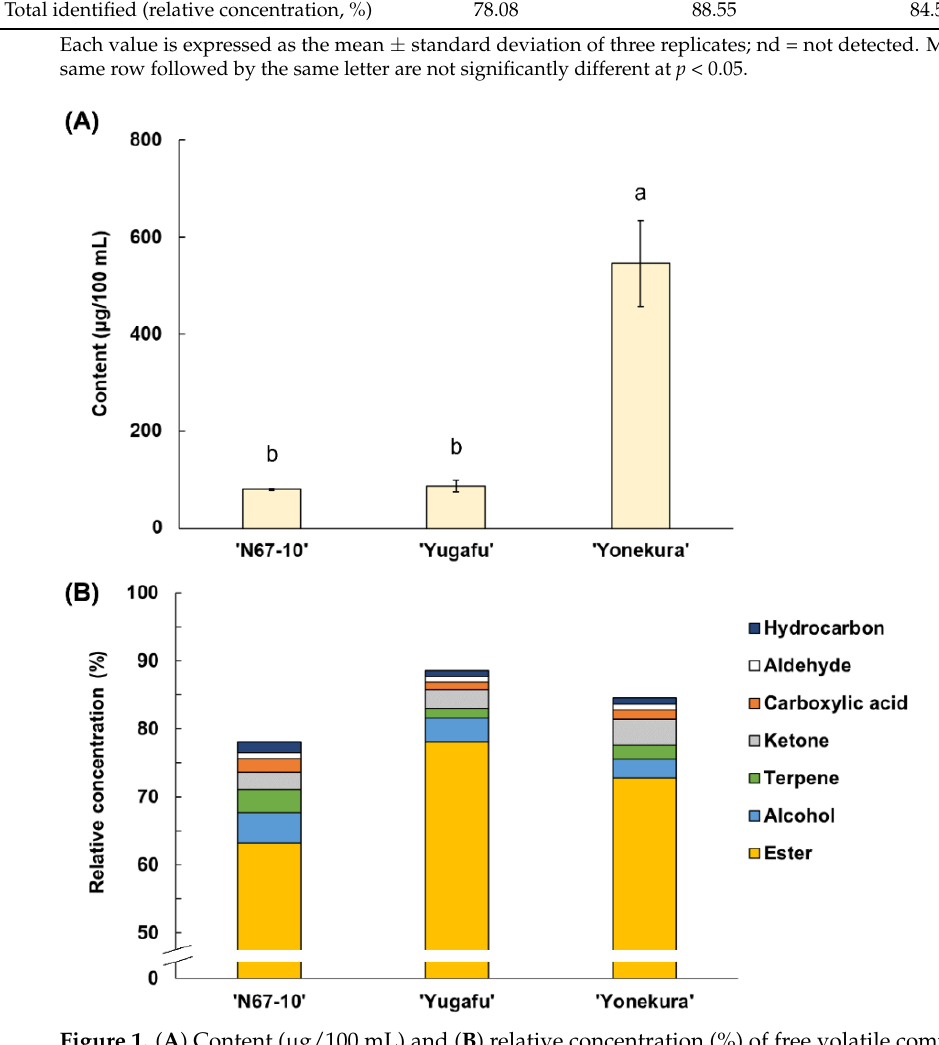
Figure 1. ( A ) Content ( µ g/100 mL) and ( B ) relative concentration (%) of free volatile components of Okinawan pineapple. Each value is expressed as the mean ± standard deviation of three replicates. Means followed by the same letter are not significantly different at p < 0.05.